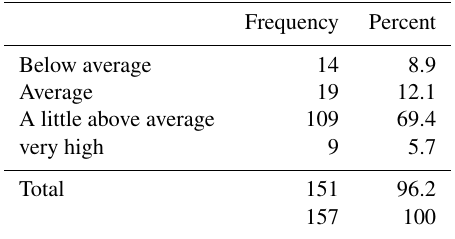
Table 3. Effect of Dam on Livelihood/Standard of Living of